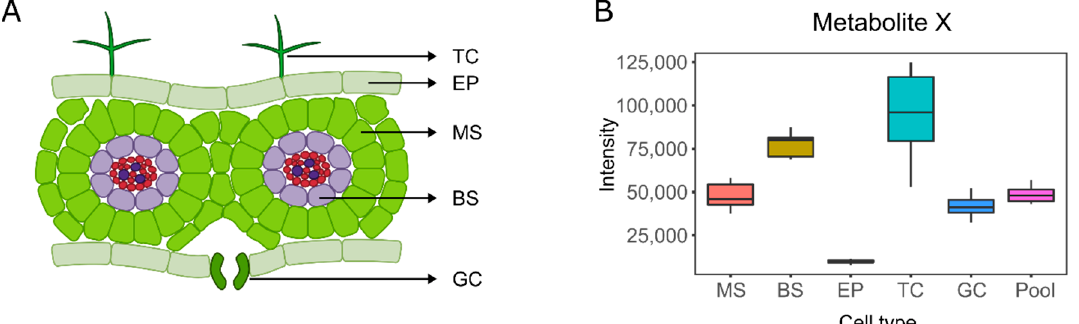
Figure 1. The effect of cell heterogeneity, exemplified by different cell types in a leaf, in metabolomics analysis. ( A ) Diagram of a leaf cross-section depicting typical cell types. ( B ) Hypothetical values for a metabolite X differentially accumulated in multiple cell types highlighting the averaging effect of pooling cells together in a traditional metabolomics experiment. Trichomes (TC), epidermal cells (EP), mesophyll cells (MS), bundle sheath cells (BS), and guard cells (GC).